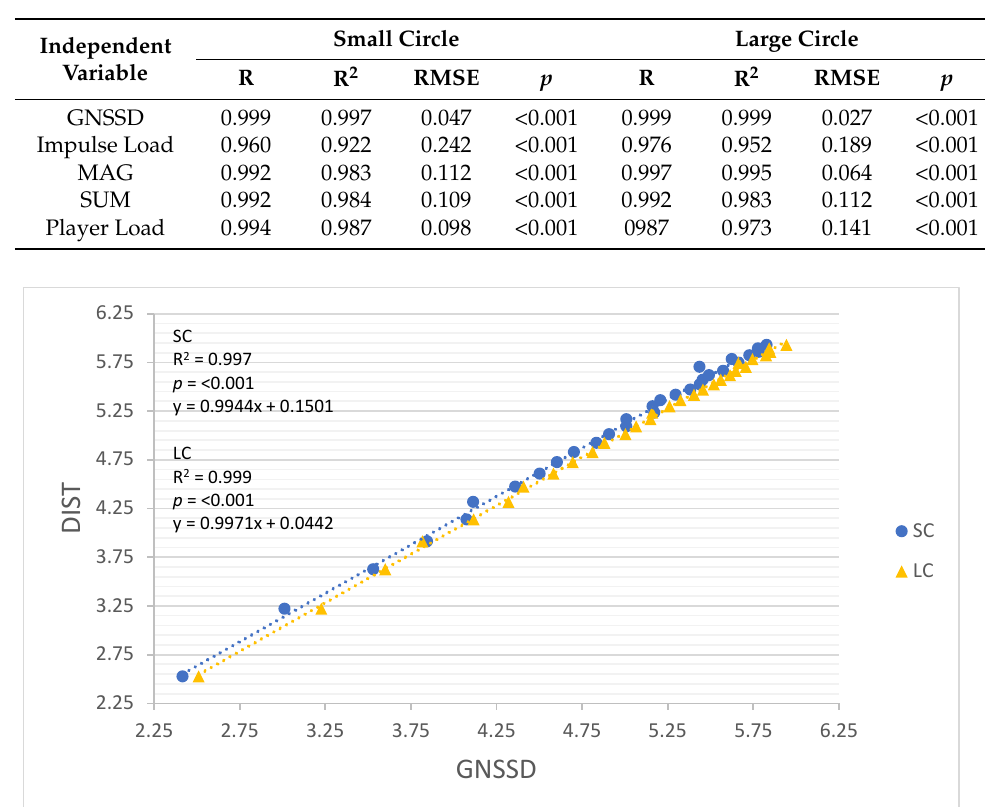
Figure 2. The relationship between log transformed DIST and GNSSD around the small circle and the large circle. SC = small circle, LC = large circle.